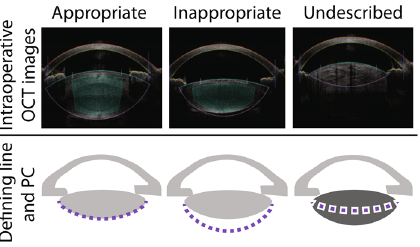
Figure 1. The lines defining the posterior capsule (PC) were classified into three groups by visual inspection. The intraoperative integrated optical coherence tomography (OCT) images from the all treatment summaries were classified into three groups; appropriate PC line, inappropriate PC line and undescribed. An appropriate PC line was defined as the line defining PC accurately aligned with the PC of the intraoperative OCT image (left column). An inappropriate PC line indicates the line defining PC clearly misaligned with the PC of the intraoperative OCT image (middle column). Because of dense cataract, the line defining the PC is automatically defined as minimum lens thickness (right column: undescribed).